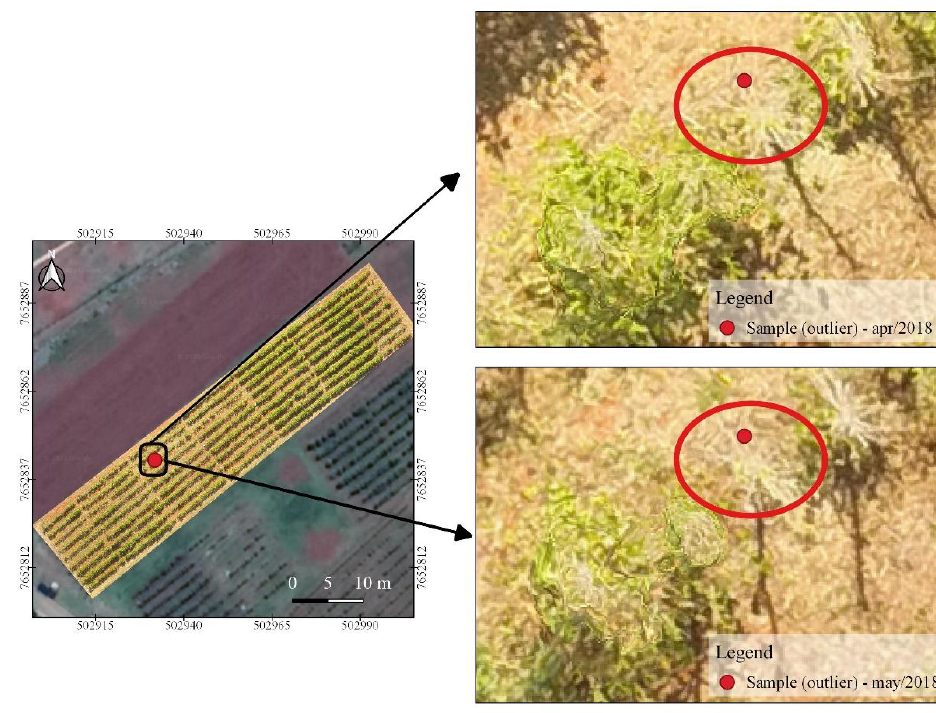
Figure 3. Outlier example.